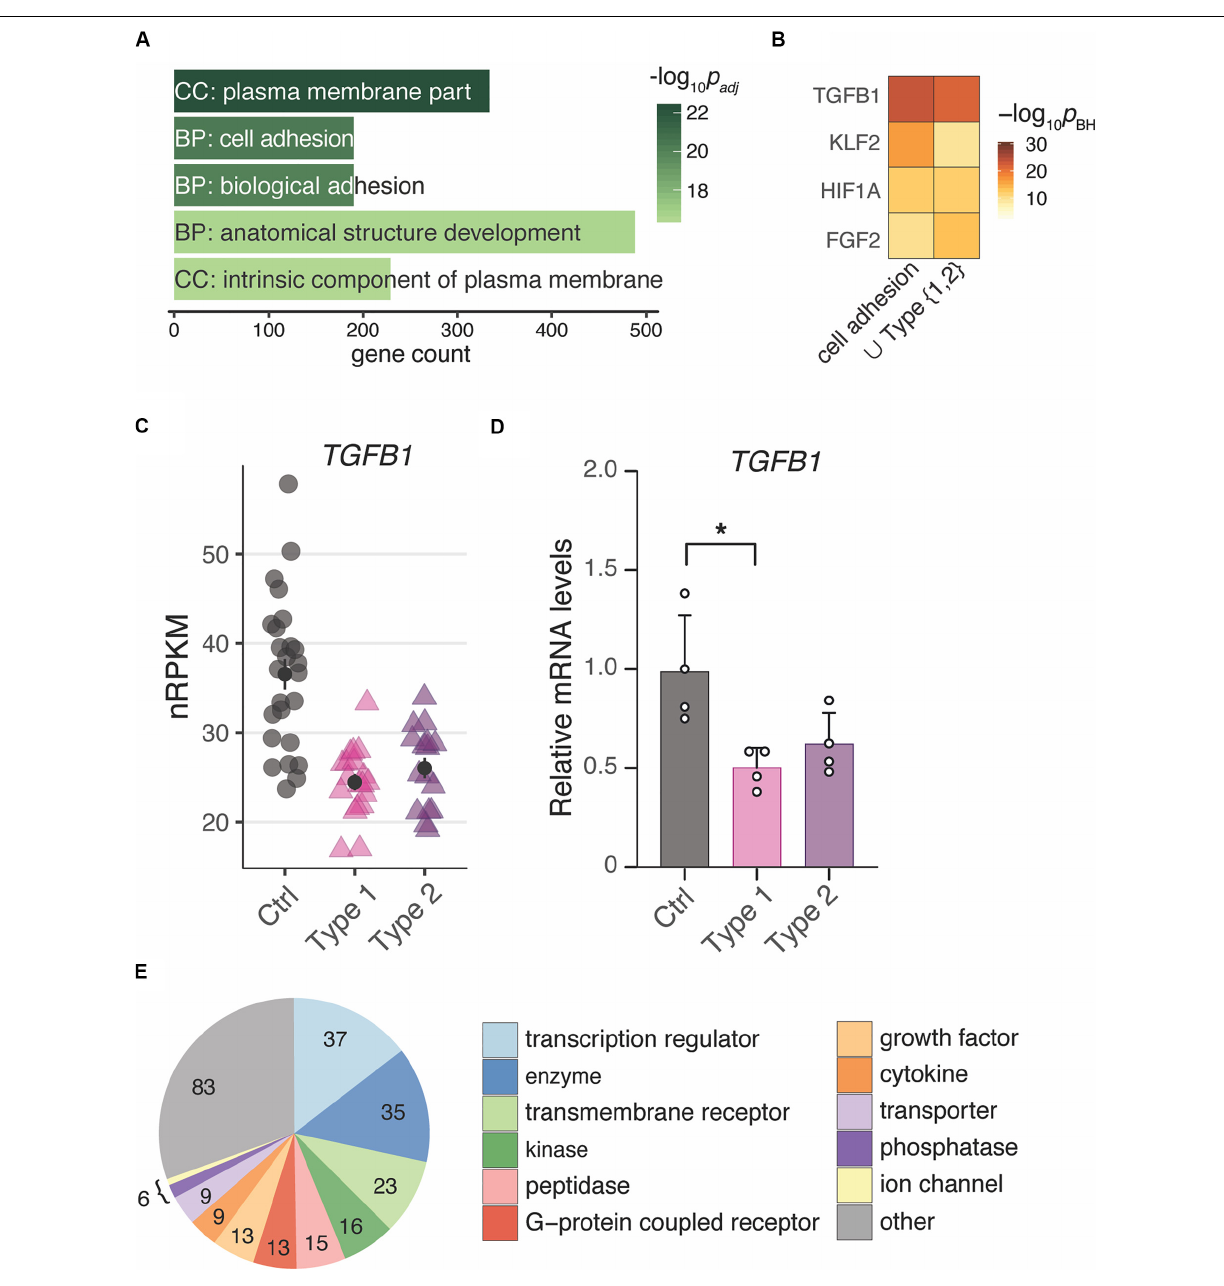
FIGURE 3 | Changes of gene expression in both types of MRKH point to regulators of cell adhesion and development. (A) Enrichment analysis identified several significantly overrepresented Gene Ontology terms among the 2121 DEGs (union indicated in Figure 1B ). Top five terms with number of associated genes are shown according to their significance. CC, cellular compartment; BP, biological process. (B) Comparison of predicted upstream regulators for the DEGs underlying the cell adhesion term (see panel A ) as well as all 2121 DEGs (union from Figure 1B ) based on Ingenuity Pathway Analysis. Top three significant regulators for each gene set shown. (C) Expression changes for TGFB1 plotted as individual data points with mean ± SEM. (D) RNA-seq results of TGFB1 were verified by RT-qPCR. mRNA levels relative to controls plotted as individual data points with mean ± SEM. Significances based on one-way ANOVA with * p < 0.05. (E) Among the 253 predicted interactors of TGFB1 differentially expressed in both types of MRKH, transcriptional regulators represent a largest subgroup. Interactors identified based on Ingenuity Pathway